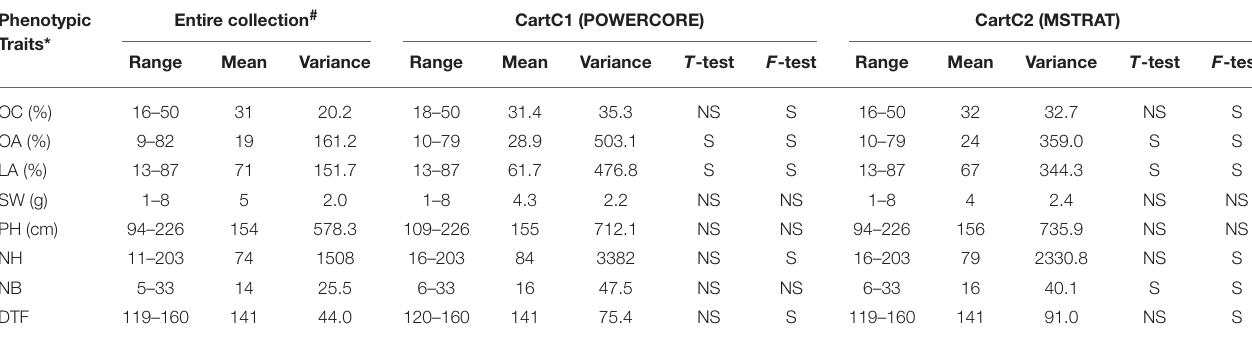
TABLE 8 | Ranges, means, and variances for the entire collection and composite core collections, CartC1 and CartC2. Phenotypic Traits*